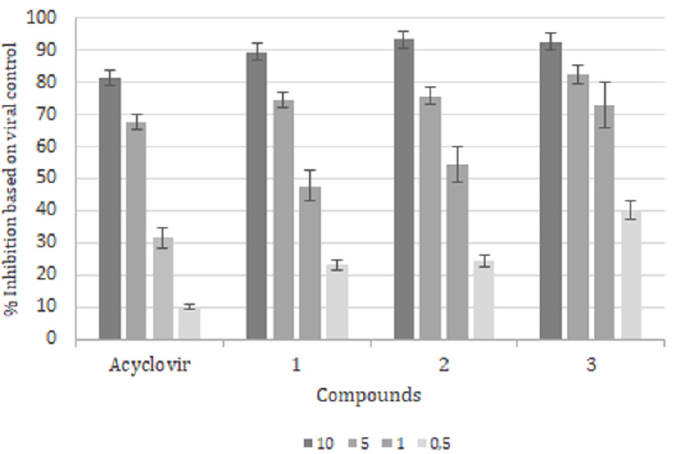
Figure 2. Effects of 2-aminomethyl-3-hydroxy-1,4 naphthoquinones encapsulated in liposomes on HSV-1 replication. After infection (MOI = 0.1) Vero cells (3 × 10 5 cells/well) were grown in the presence of 0.01 to 10 μ M of compounds 1–3 for 24 h. Inhibition was calculated based on plaque-forming units of viral control. The results were expressed as the Mean ± SD of three independent experiments. p < 0.05 control group.